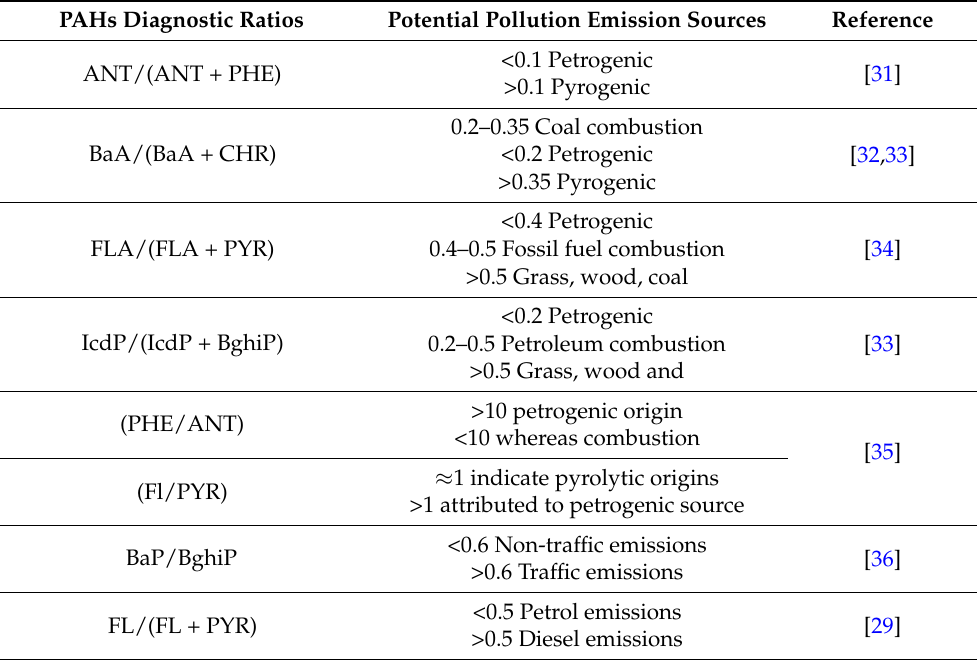
Table 2. Selected PAHs diagnostic ratios.